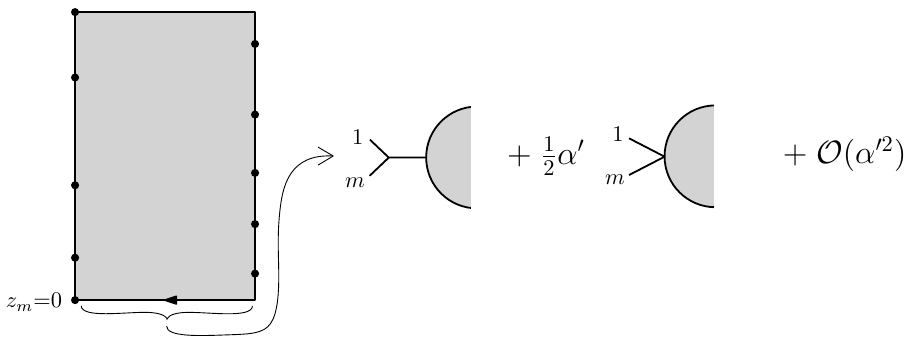
Figure 5 . Graphs appearing in the field theory limit of the bulk